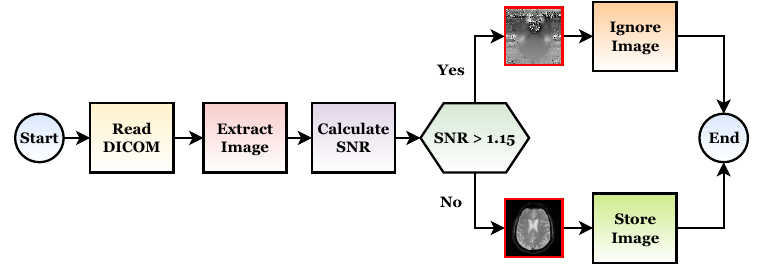
Figure 7. The data conversion and cleaning steps applied on the ADNI